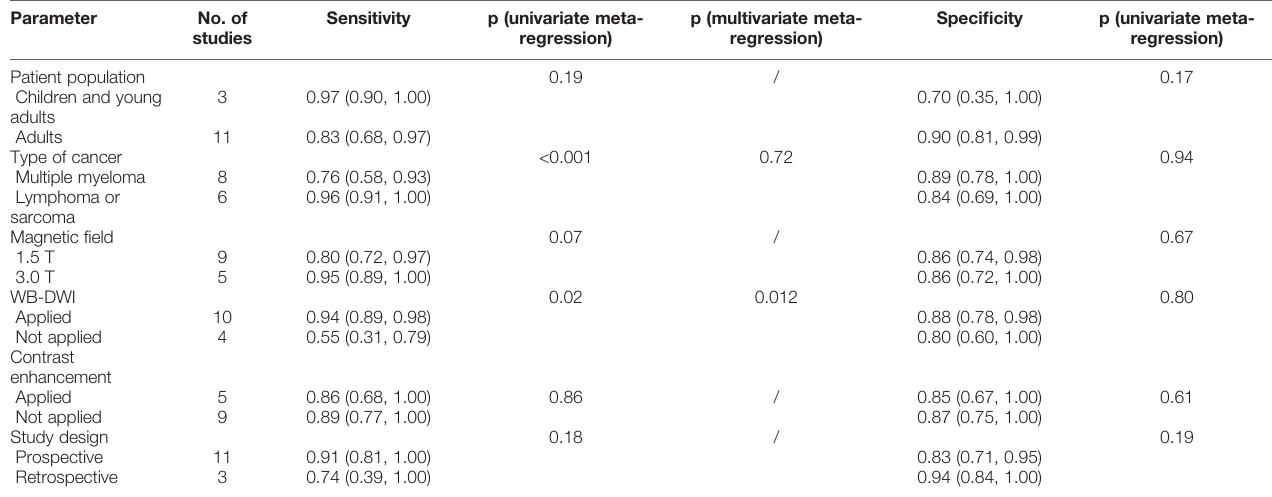
TABLE 2 | Subgroup analysis and